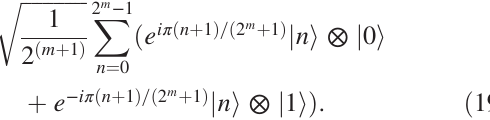
FIG. 2. Heisenberg-limited phase estimation circuit for learning the eigenphase of W with m bits of accuracy with Holevo variance 2 j L ih L j ⊗ 1 − 1 Þ and χ π 2 = 2 2 ð m þ 1 Þ , where R prepares the resource state from Eq. (17), which was shown to be optimal in L is ð m and the inverse quantum Fourier transform ( QFT † ) have gate complexity Ref. [56]. Both χ m compared to the overall gate complexity of phase estimation, which scales as O ð 2 m Þ . The controlled R L and W ¼ R implemented as shown in Fig. 1. As a consequence of Eq. (16), this circuit involves only 2 m − 1 applications of R applications of SELECT . Note that the first unit of R · W · R is replaced by W controlled on the zero state of an ancilla in order to help L L = λ Þ and arccos ð E = λ Þ þ π disambiguate the outcomes of arccos ð E k k